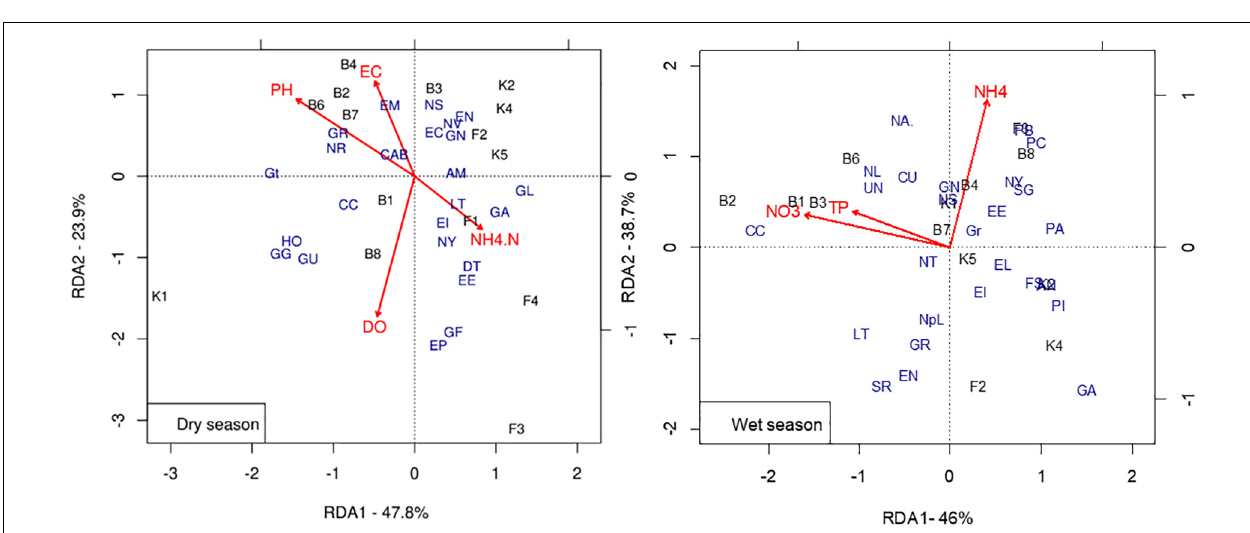
FIGURE 5 | Redundancy analysis triplot of diatom taxa, environmental variables, and sites (see Supplementary Table S6 for full names of taxa codes and Supplementary Table S1 for the site codes). DO, Dissolved Oxygen; EC, Electrical Conductivity; NH 4 .N, Ammonium-Nitrogen; NO 3 , Nitrate Nitrogen; TP, Total